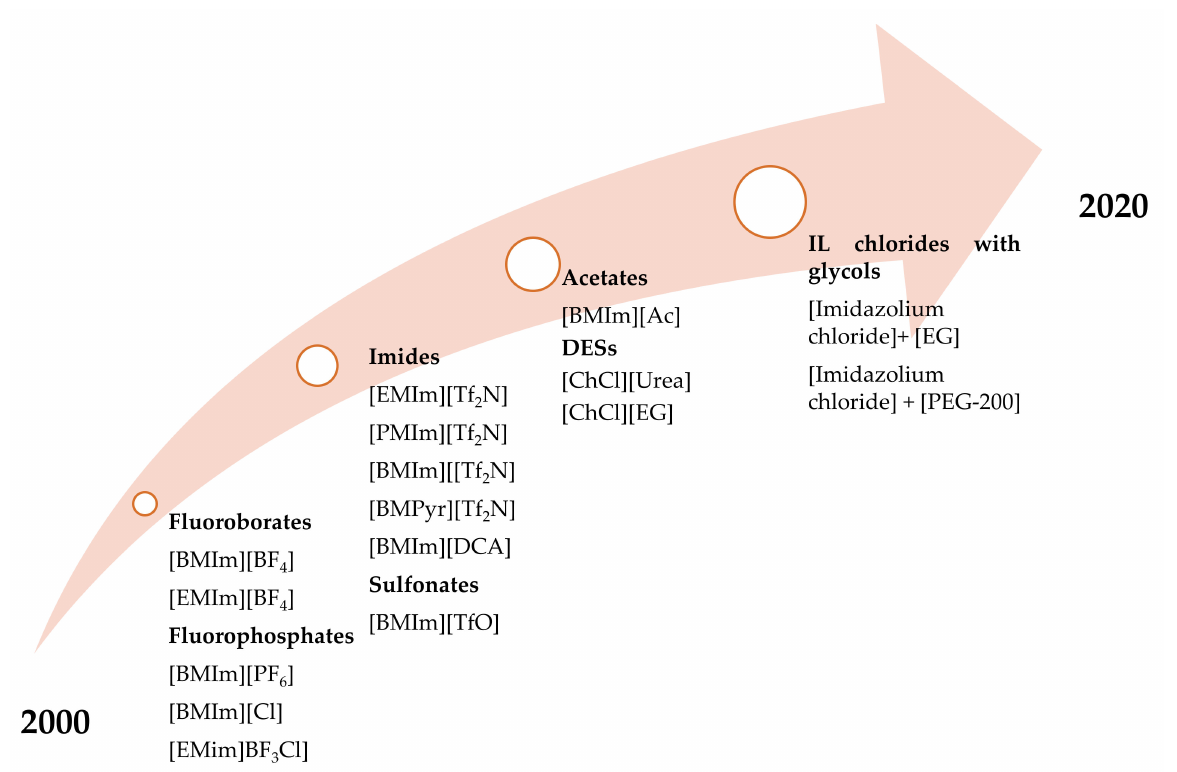
Figure 3. Developments of the ILs, DESs in CO 2 electroreduction covering the period